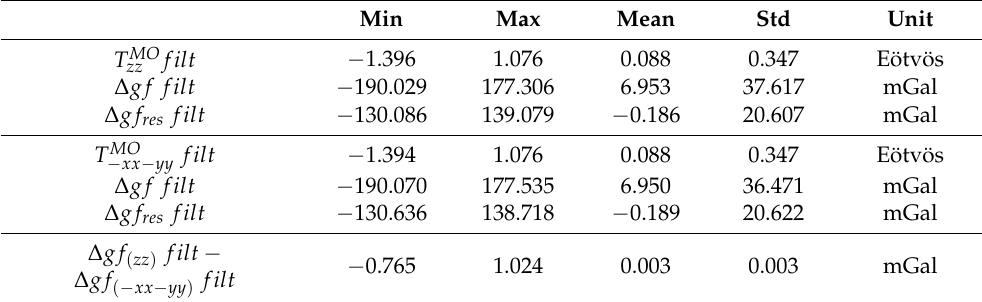
Table 4. Statistical values of the WL-filtered DC results for the entire GOCE time